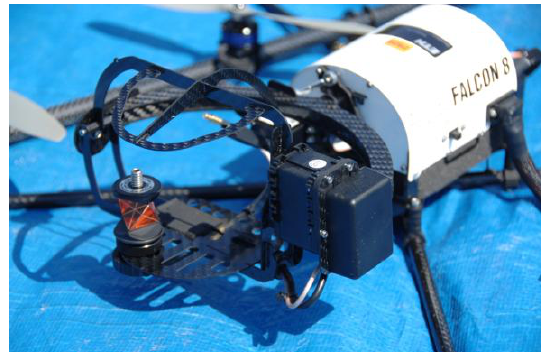
Figure 3. Leica 360° mini prism mounted on the Falcon in order to accomplish the track with the total